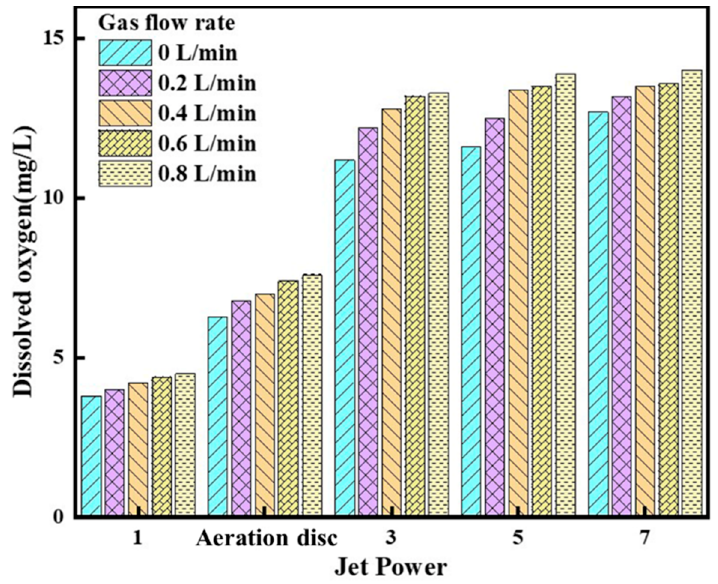
Figure 10. Dissolved oxygen amount in the solution at different jet powers and flow rates.